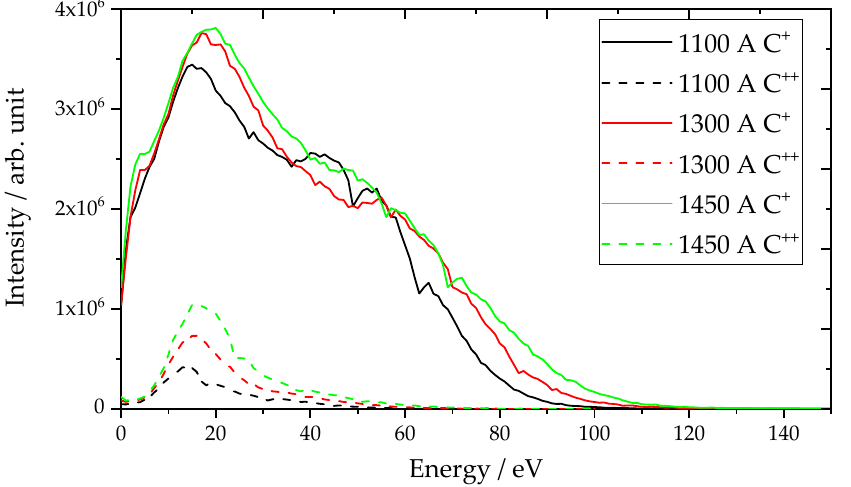
Figure 2. Energy distribution of single- and double-charged carbon ions at 1100–1450 A. Table 2. Mean energy of single- and double-charged carbon ions at 1100–1450 A arc current. Current